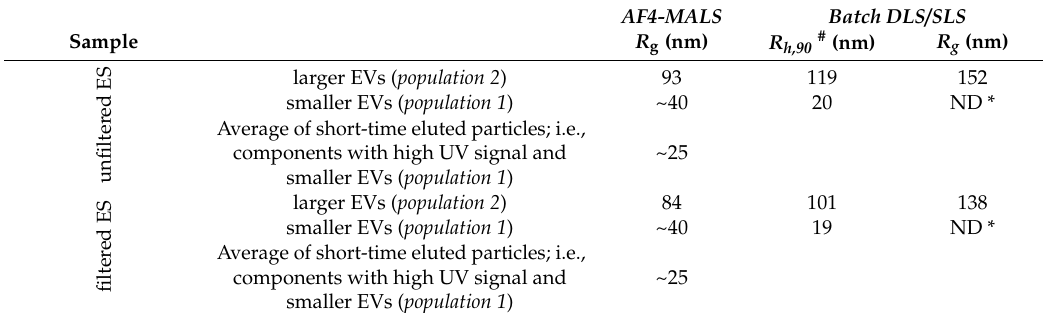
Table 1. Radius of gyration ( R g ) as determined by AF4 / UV-MALS as well as R h,90 and R g derived from batch DLS / SLS for di ff erent populations in the exosome standard.